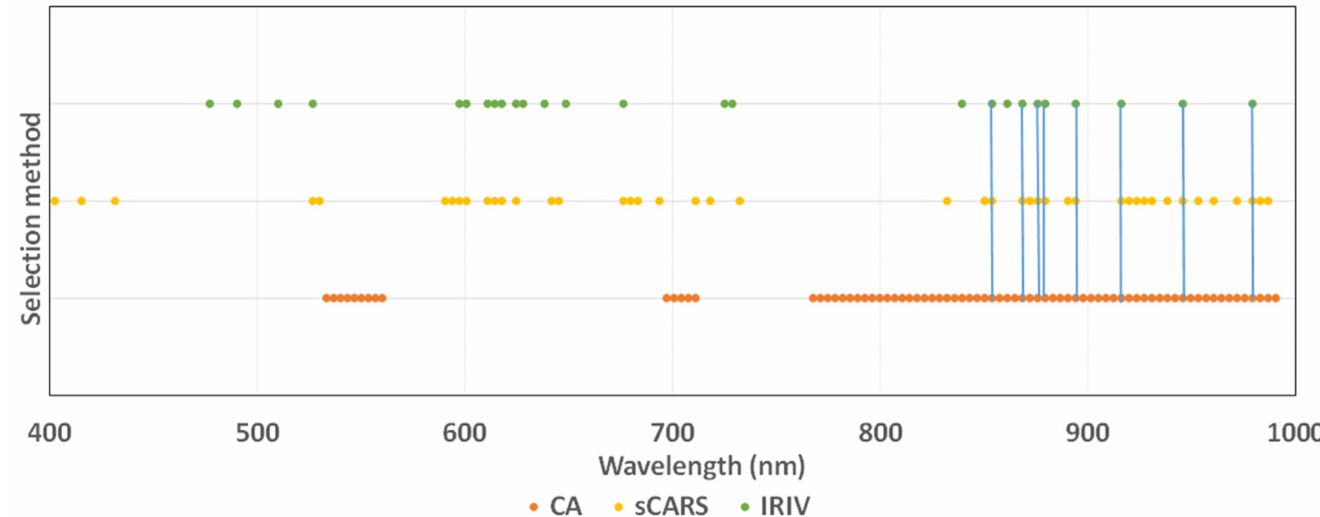
Figure 9. Comparison chart of optimal variable distribution.